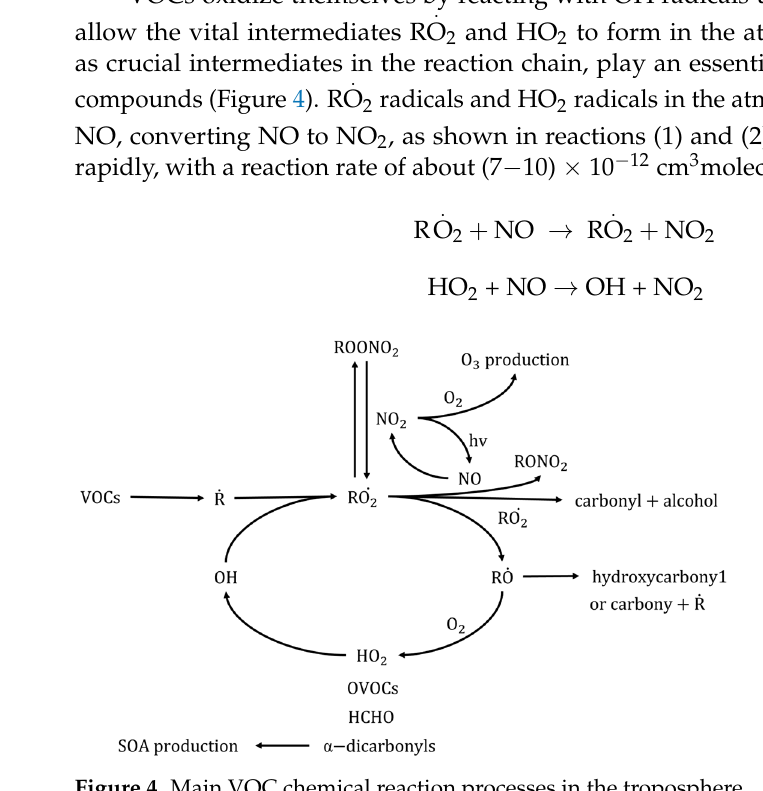
Figure 4. Main VOC chemical reaction processes in the troposphere. R O 2 also reacts with HO 2 to produce organic hydroperoxides (ROOH) and oxygen at a reaction rate of about 10 − 11 cm 3 molecule − 1 s − 1 . The reaction has a significant negative temperature effect